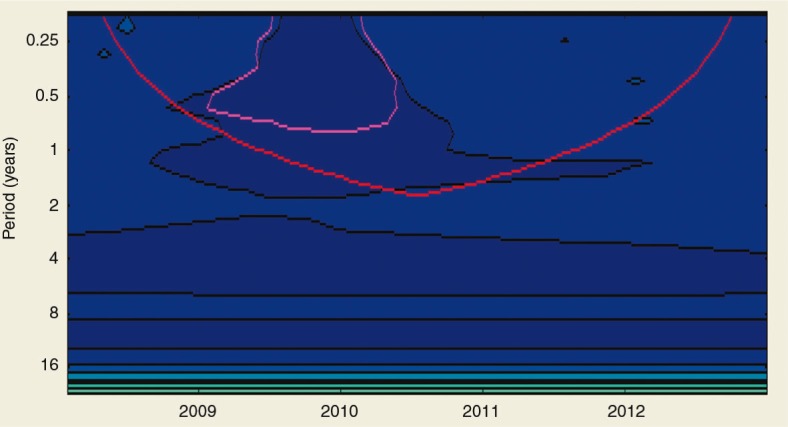
The cyclic pattern of the ILI from 2008 to 2012. The red line limits the statistical significance: . The pink line is the area of statistical significance: .  Dark blue color represents the strongest cyclic pattern.  Lighter blue color represents weaker cyclic pattern. Color density represents characteristics of seasonality, of which areas in circled pink displayed the level of statically significance. This figure indicates that the period from 2009 to mid-2010 was statistically significant. However, this period was not enough to show the ILI epidemic.